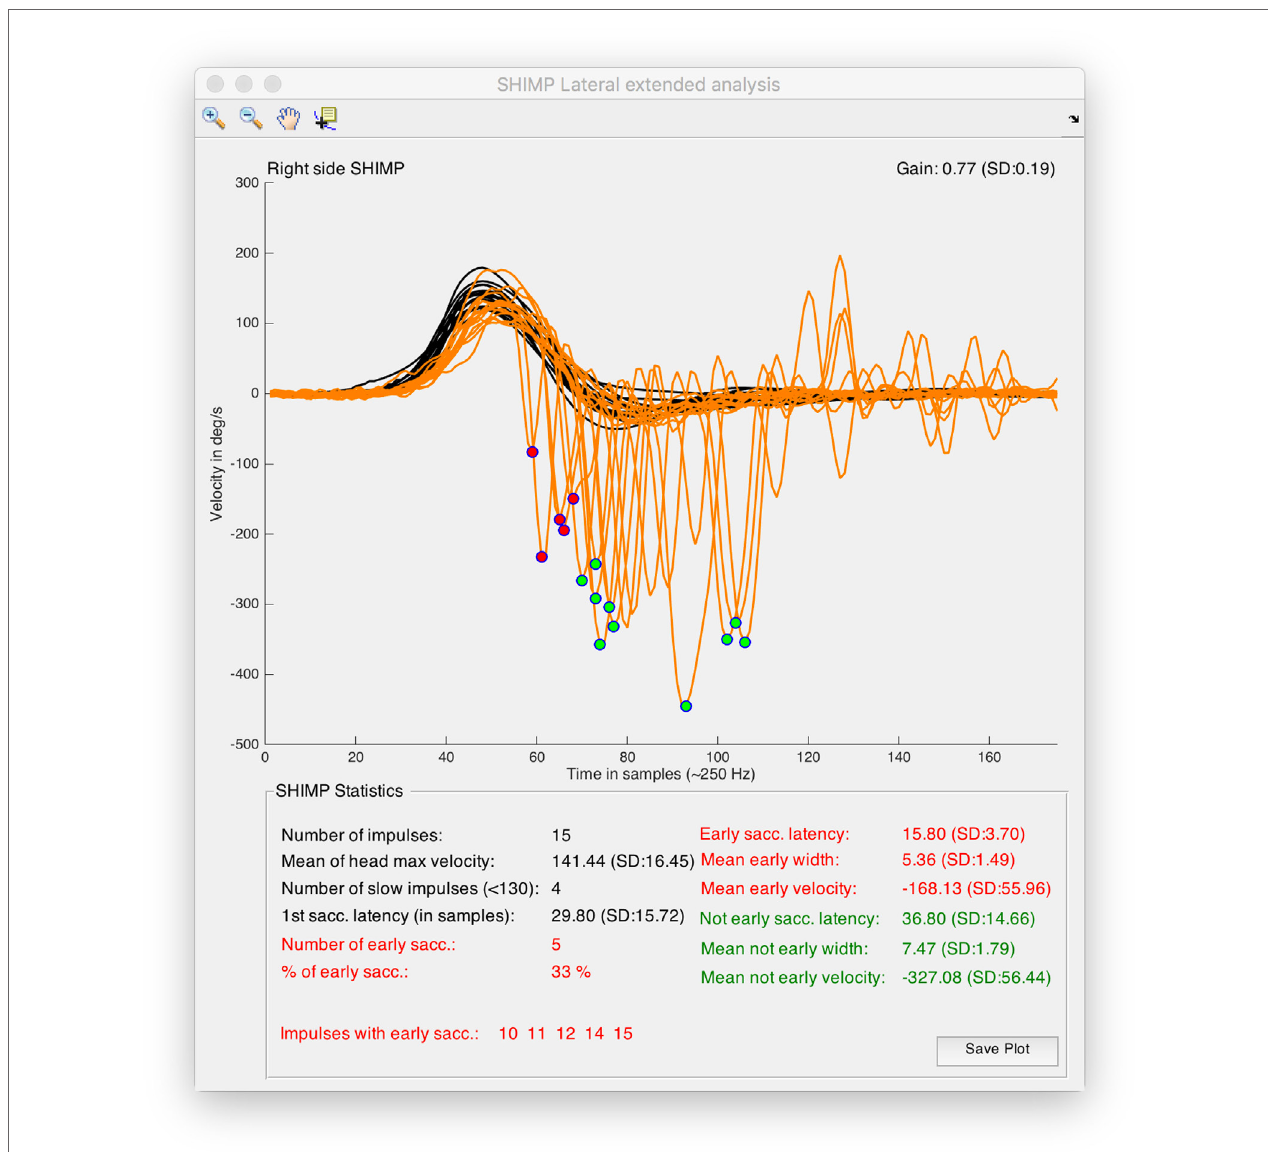
FigUre 4 | Output window obtained from suppression head impulse paradigm (SHIMP) analysis tool of HITCal running on macOS ™ High Sierra ™ computer. Real SHIMP data (left side) is computed, on the superior half of the window SHIMP is plotted with the detected and classified saccades were marked with red and green circles. On the top of the plot there are the plot navigation tools, include a data cursor view to allow manual measurement of the plots. On the inferior half of the window statistical data from SHIMP test analysis is outputted, also in this part red color are used for the computed results of the detected early SHIMP saccades, and green color are used for the computed results of the detected not early SHIMP saccades, black color is used for the head impulse analysis and also for the first saccade analysis, where first saccades are all the first detected saccades for each head impulse computing both the early and not early classified